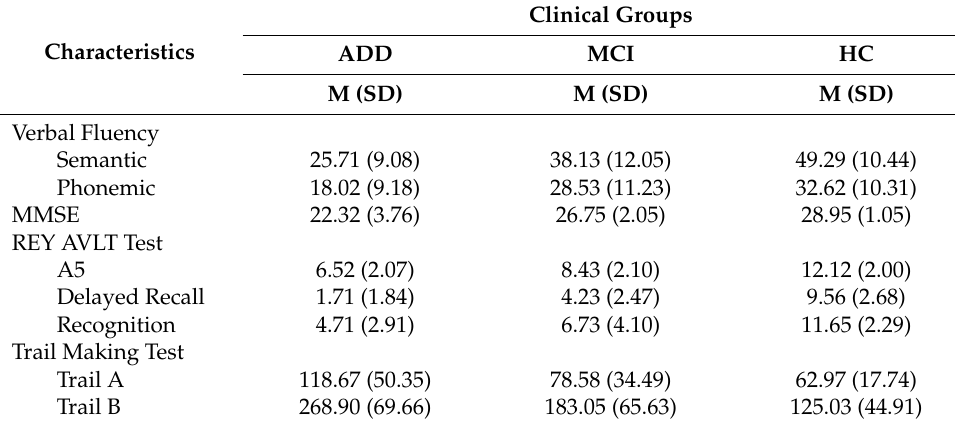
Table 3. Cognitive measures of the clinical groups.